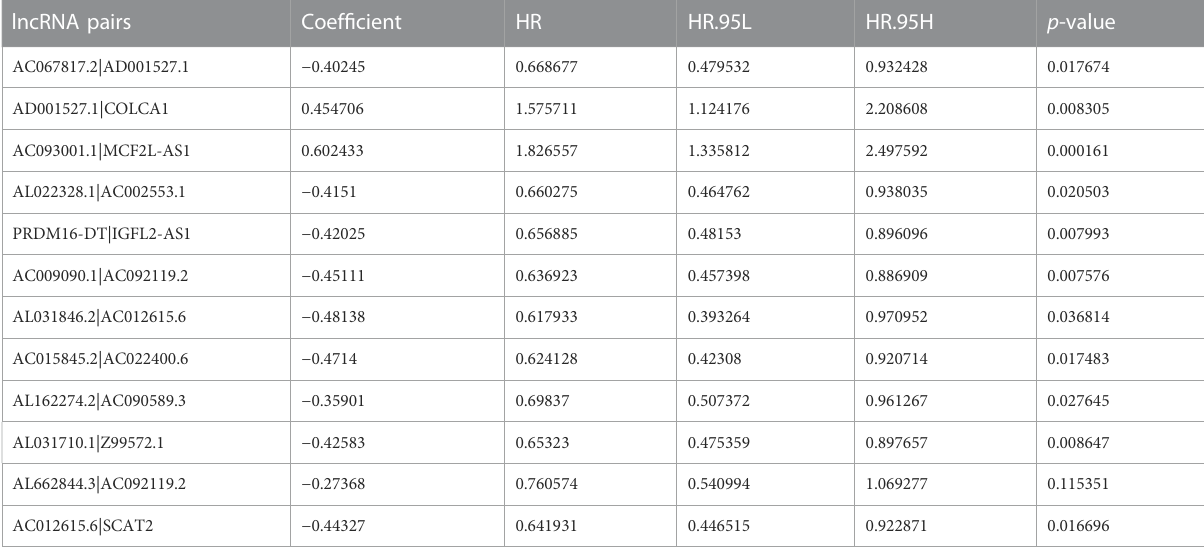
TABLE 2 Analyses of regressive coef fi cients of 12 pairs of lipid metabolism-related lncRNAs to Cox associated with results. lncRNA